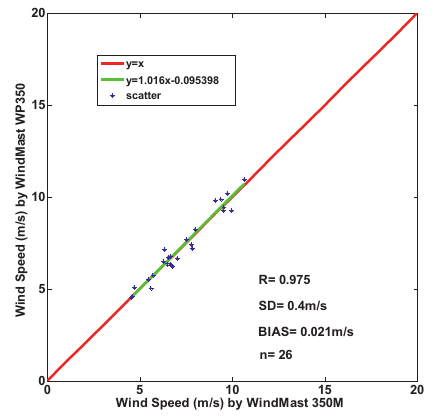
Figure 8. Scatter diagram of 150m wind speed (10 mins) of 350-M and WP350 As presented in the THI diagrams, the wind profiles observed by 350-M system fits well with the results from WP350 system after data correction and retrieval. 10-minute average horizontal wind speed at the height of 150 meters were selected for the statistical comparison in order to make more analysis of the wind speed details, as presented in Figure 8. The number